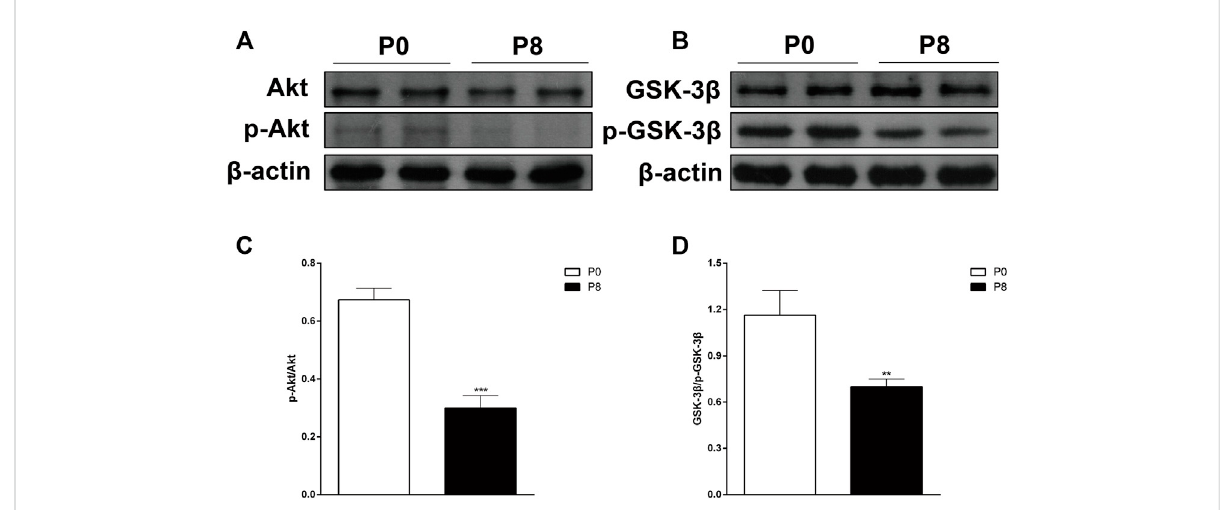
FIGURE 6 Effects of rapid pacing on Akt/GSK-3 β in the rabbit atrium. (A) Akt and p-Akt protein levels after rapid pacing stimulation for 8 h. (B) GSK-3 β and p-GSK-3 β protein levels after rapid pacing stimulation for 8 h. (C) Quantitative analysis of p-Akt protein levels, *** p < 0.001 vs. P0. (D) Quantitative